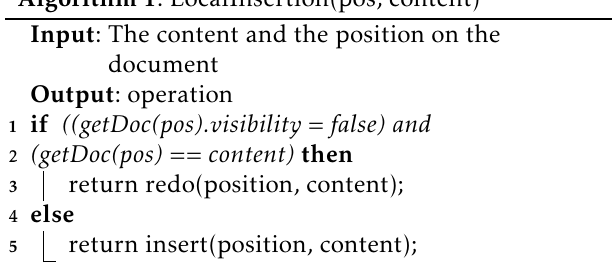
Algorithm 1 : LocalInsertion(pos, content)